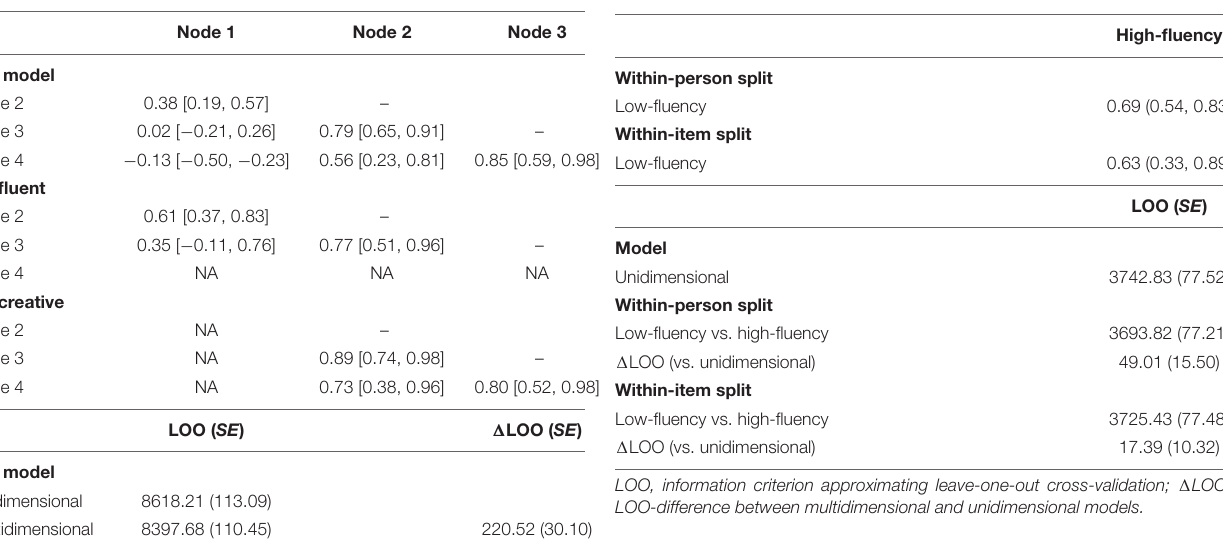
TABLE 2 | Correlations of latent variables and model comparison results for a differentiation of low-fluency and high-fluency creative quality for be-fluent instructions only.